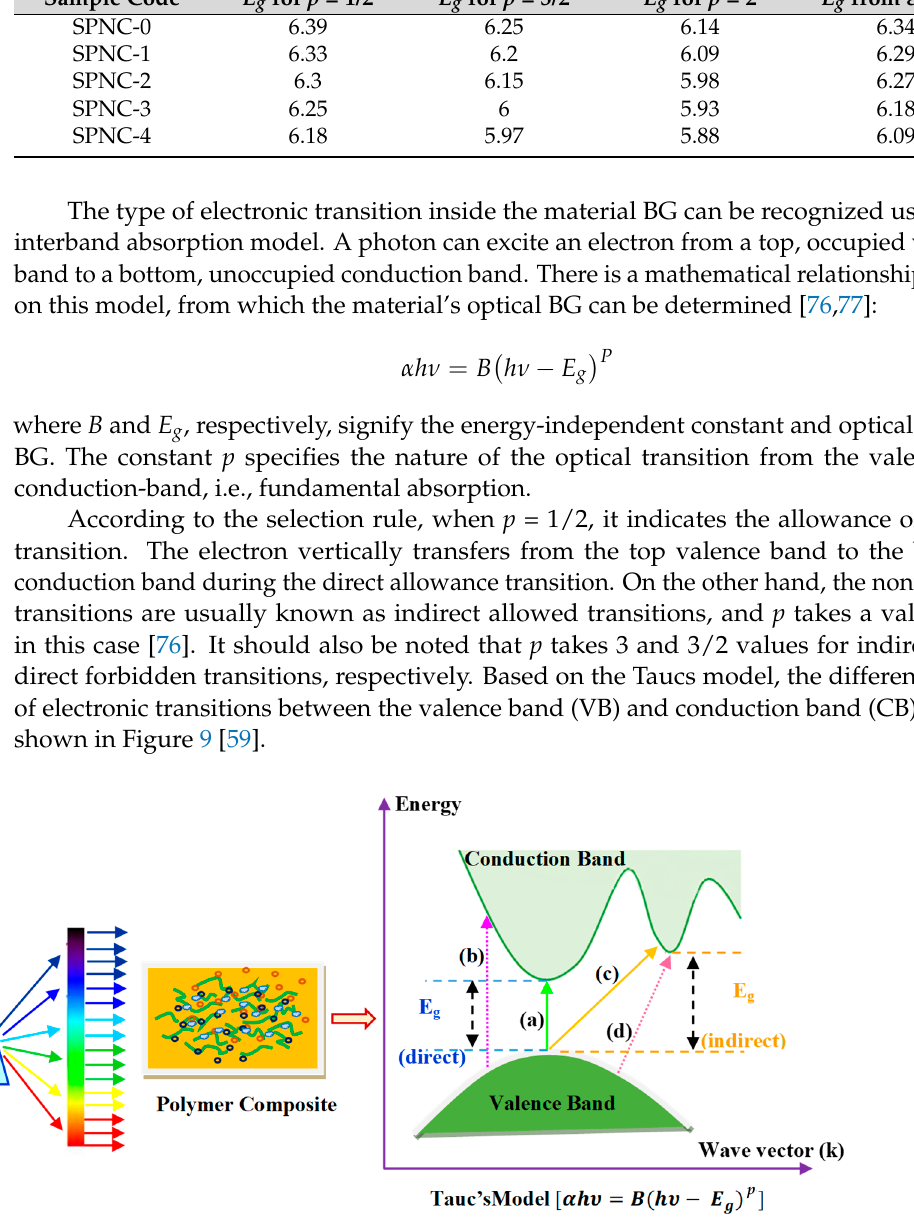
1 p versus h υ ] and ε i plot.